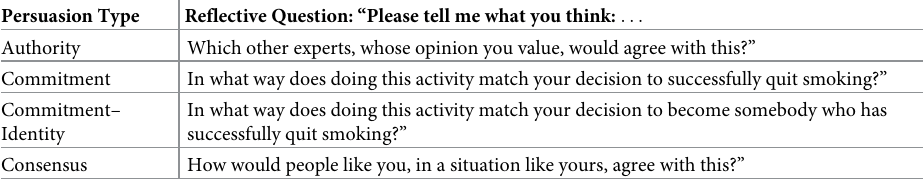
Table 3. Reflective questions for authority, commitment, and consensus.